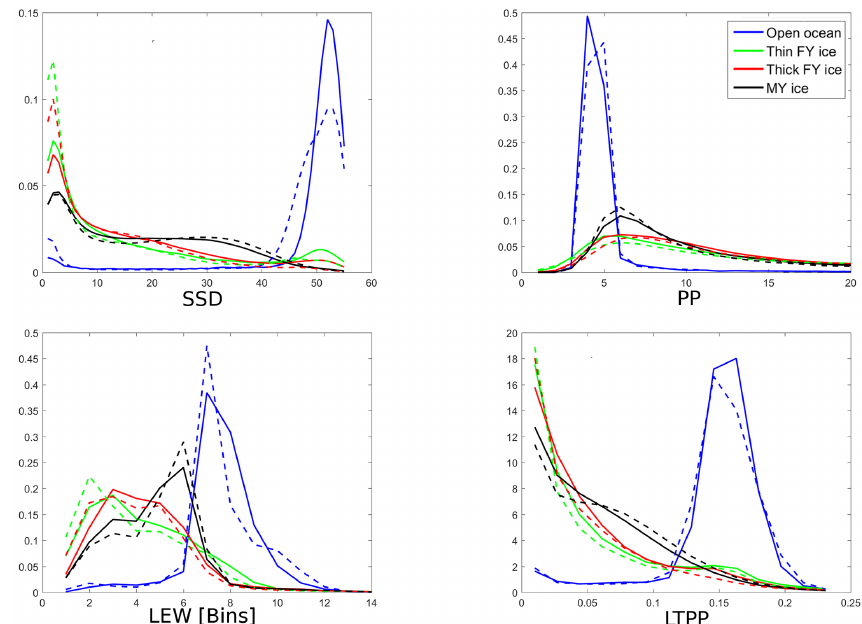
Figure 4. Normed distributions of waveform parameters: SSD (top left panel), PP (top right panel), LeW (low left panel), and LTPP (low right panel) for the period 1–15 March (solid lines) and 16–30 March (dashed lines)